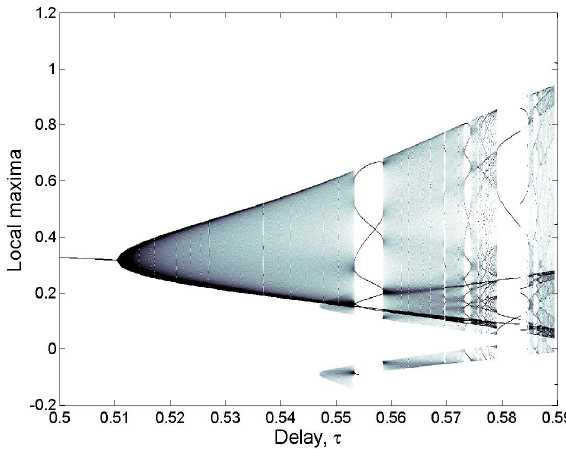
Figure 12 zooms in on the distribution of local maxima